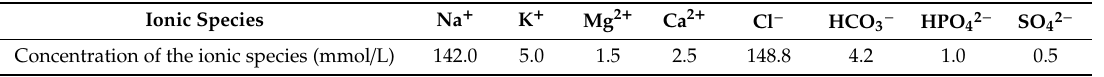
Table 1. Concentrations of the ionic species used in simulated body fluids (SBF) preparation.